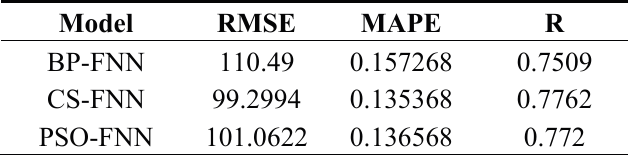
Table 1. Performance statistics of the models on testing dataset in the first scenario.